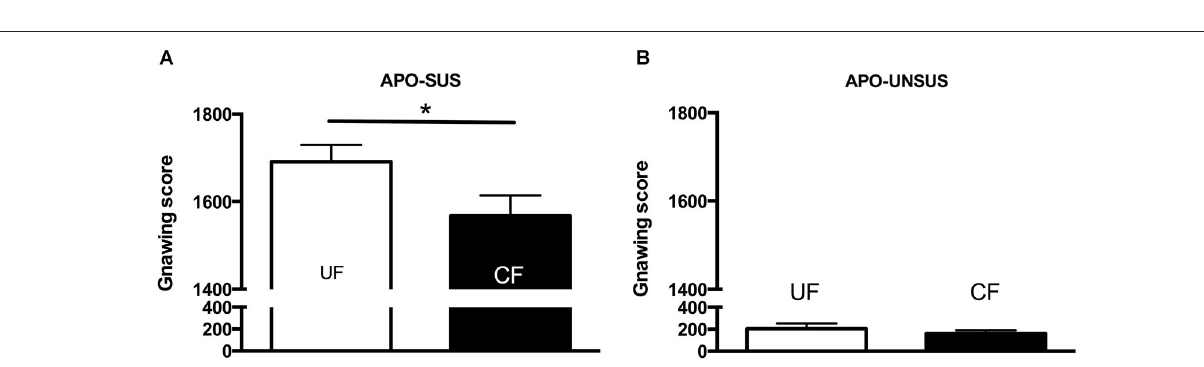
the open field in APO-SUS rats at adulthood (male: t ( 99 ) = − 0.17, n.s., Figure 4A ; female: t ( 78 ) = − 1.1, n.s., Figure 4C ). BEHAVIOR OF THE APO-SUS AND APO-UNSUS MOTHERS AFTER